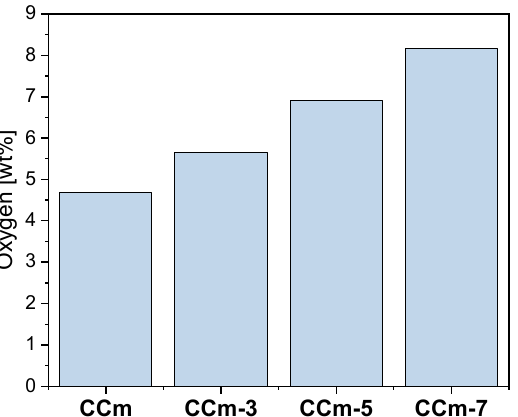
Figure 19. The amount of oxygen identified on the surface of the milled Co-Cr samples, before and